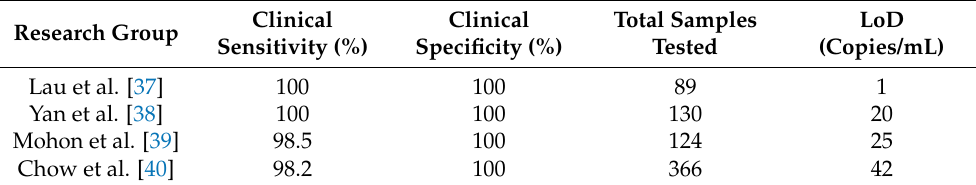
Table 1. Top-performing LAMP diagnostic tests for SARS-CoV-2.